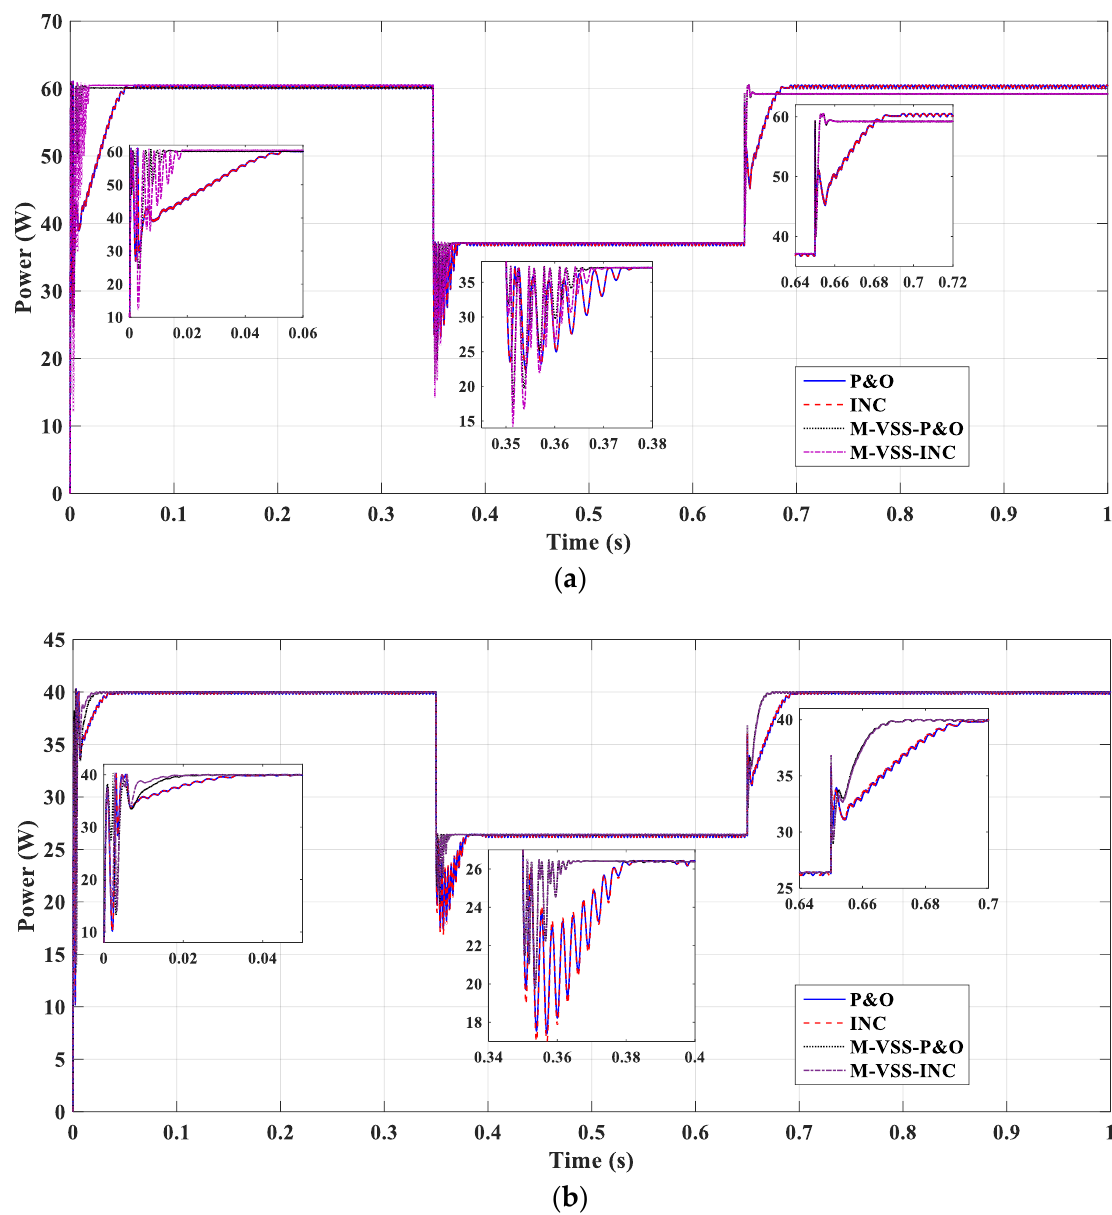
Figure 9. Cell performance under irradiance sudden variation for ( a ) MSX60 and ( b ) ST40. In contrast, with a faster response time of 367.5 ms and a minor error of 17.5 ms, both modified strategies could congregate to 37.14 W, almost the equivalent MPP of the conventional algorithms. Moreover, the enhanced algorithms succeeded in minimizing the steady-state oscillations around the MPP. In comparison to both P&O and INC (60.14 W), both modified MPPTs can perceive the abrupt spike in solar irradiance even better and faster, with an inaccuracy of just 7.2 ms and a minor reduction in power (59.52 W) in 690.4 ms.